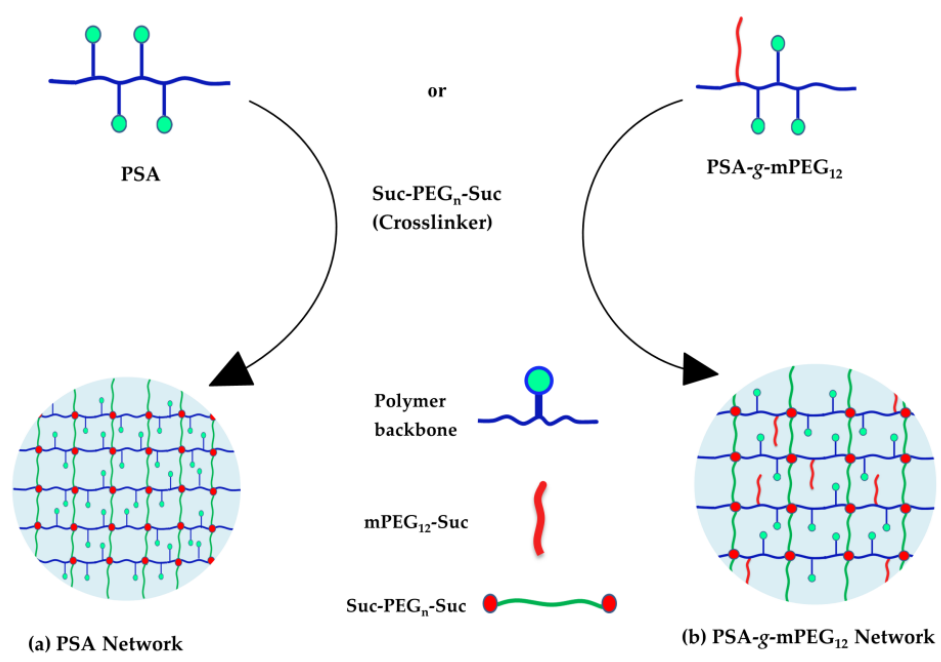
Figure 3. Presumed network formation using Suc-PEG n -Suc with ( a ) PSA or ( b ) PSA- g -mPEG 12 when the network cross-links occur ideally.